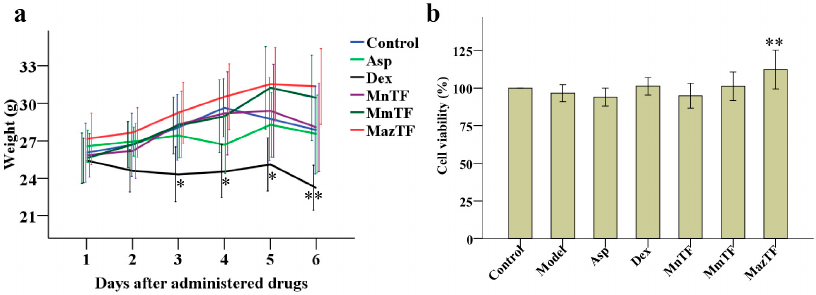
Figure 2. Effects of TFs on weight of mice ( a ) and cytotoxicity of RAW 264.7 cells ( b ). Groups of